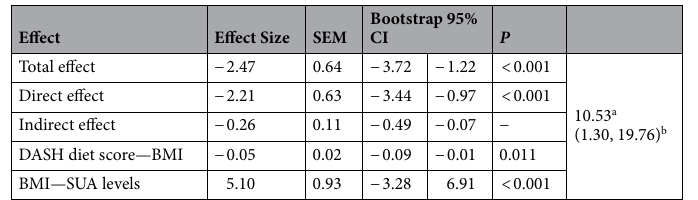
Table 5. Stratified analysis of the association between the DASH diet score and SUA levels. Model a to m: Adjusted for potential confounding factors, including gender, age,BMI, married status, occupation, education level, smoking, alcohol drinking, history of hypertension, history of diabetes, history of hyperuricemia, history of gout, family history of gout, uric-acid-lowering drug intake. *Having significant interactive effects ( P < 0.05).